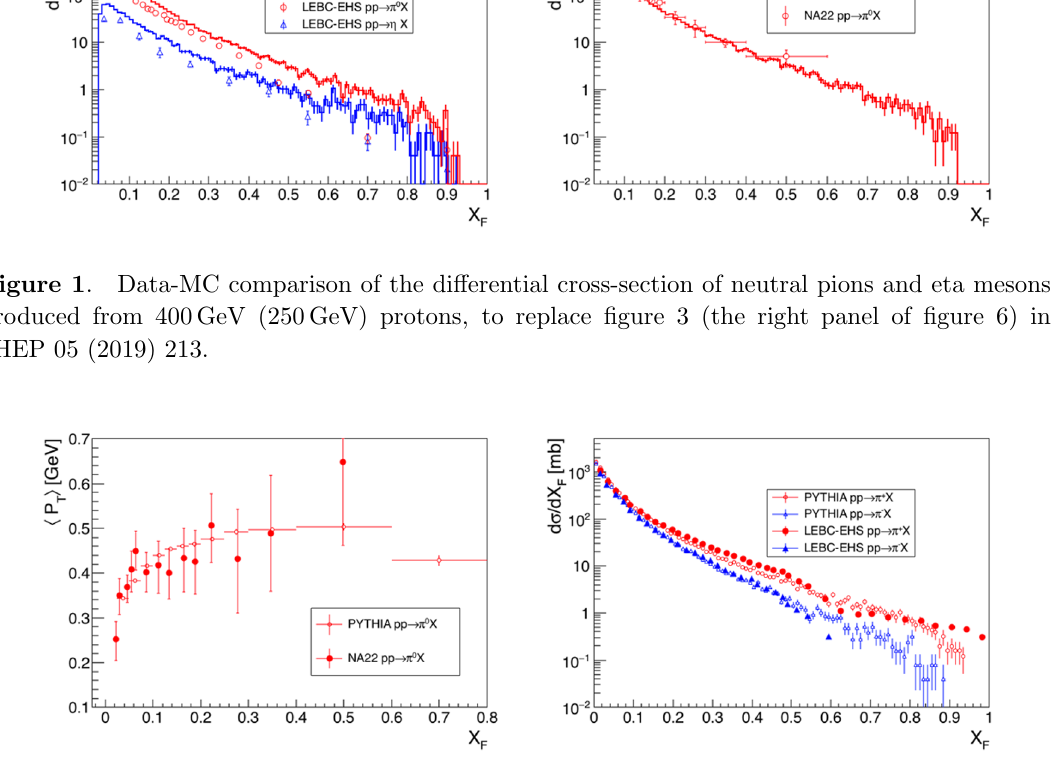
Figure 2 . Left: data-MC comparison for the average transverse momentum as a function of the Feynan X F for a beam momentum of 250 GeV, to replace (cid:12)gure 7 in JHEP 05 (2019) 213. Right: data-MC comparison of the di(cid:11)erential cross-section of charged pions produced from 400 GeV